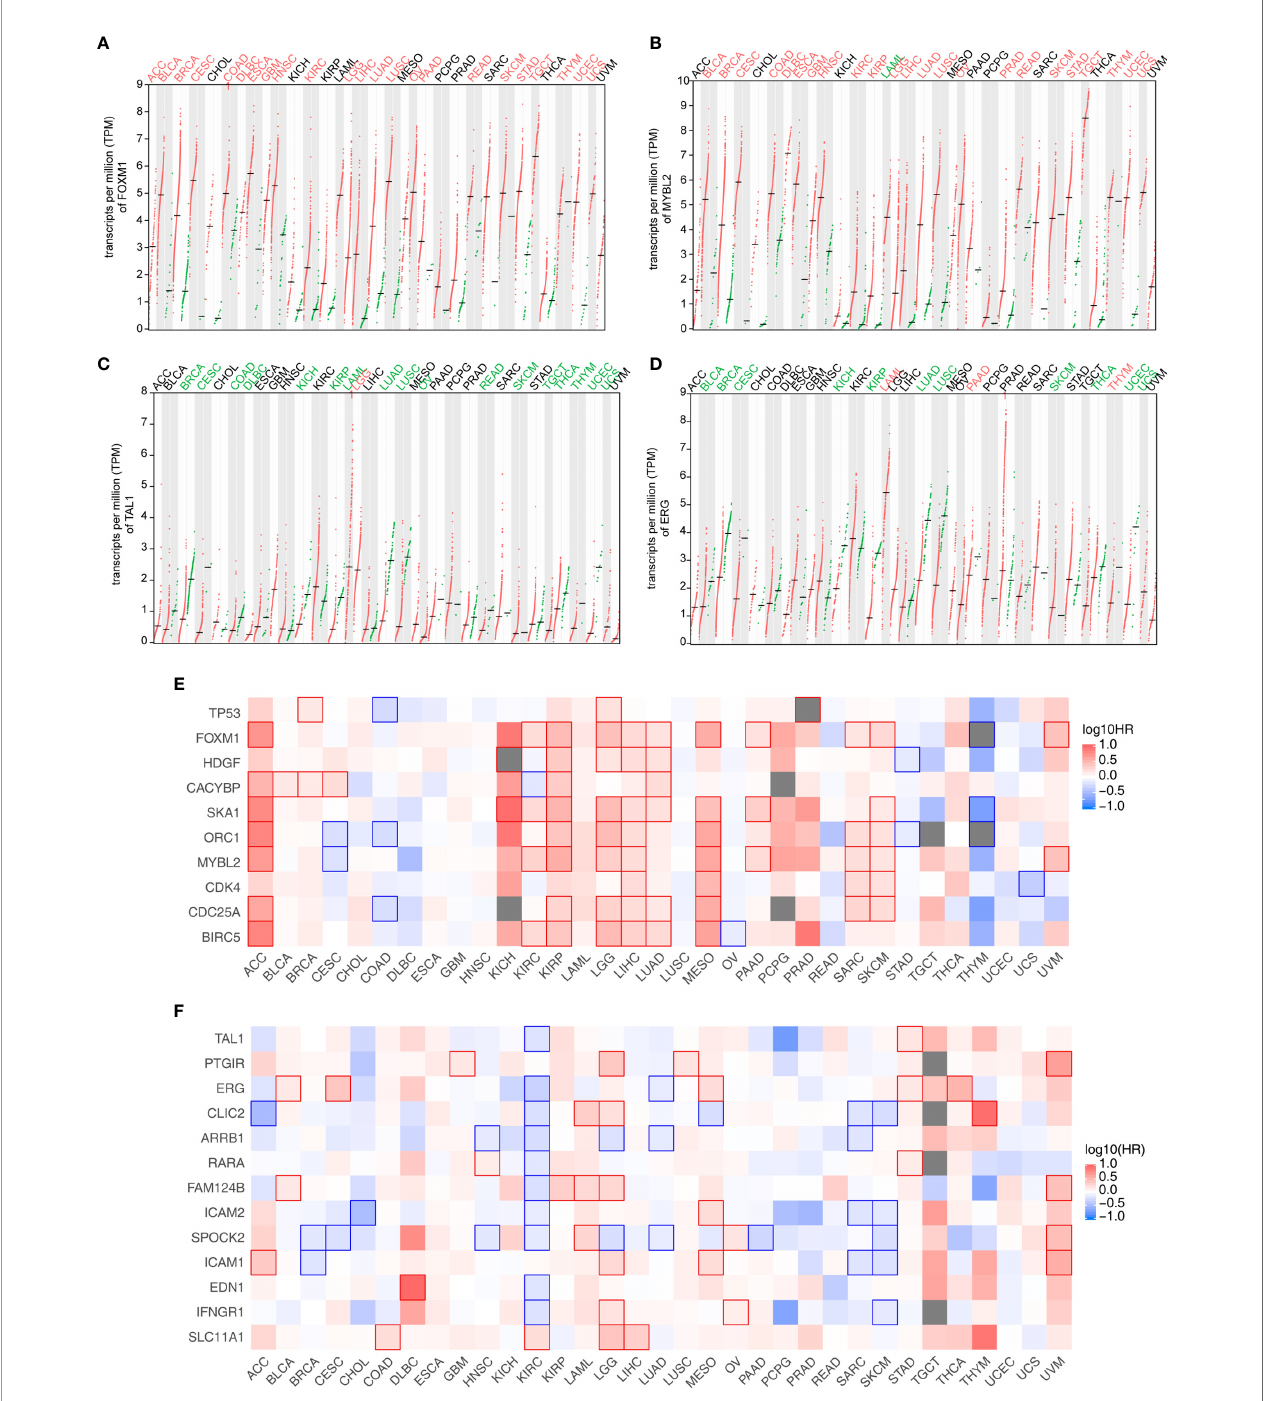
FIGURE 3 | Analysis of the expression and its correlation with the survival rate of TF and immune-related genes identi fi ed in Figure 2 . (A – D) Four TF expression pro fi les of 33 cancer datasets downloaded from the TCGA database. (A) FOXM1 and (B) MYBL2 were from the MEyellow module. (C) TAL1 and (D) ERG were from the MEblue module. Cancer names in red indicate that gene expression was signi fi cantly upregulated in tumors, and cancer names in green indicate that gene expression was signi fi cantly downregulated in tumors. (E) Association of the expression level of TF-iGENs in the MEyellow module with the patient survival rates in various types of cancer. (F) Association of the expression level of TF-iGENs in the MEblue module with the patient survival rates in various types of